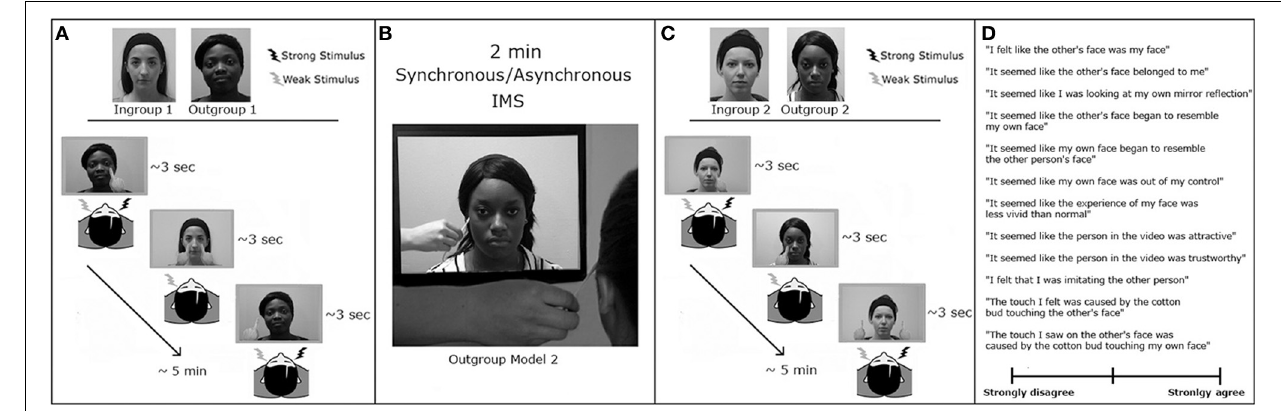
on a specularly congruent location in synchrony (in one session) or asynchrony (in the other session) with respect to the touch delivered on the participants’ face. (C) VRT measurement post-IMS. This session was similar to the one before IMS, but now the Outgroup face was the face seen during the IMS. (D) Participants were asked to rate their agreement with 12 statements about their experience during IMS, using a Visual Analog Scale.